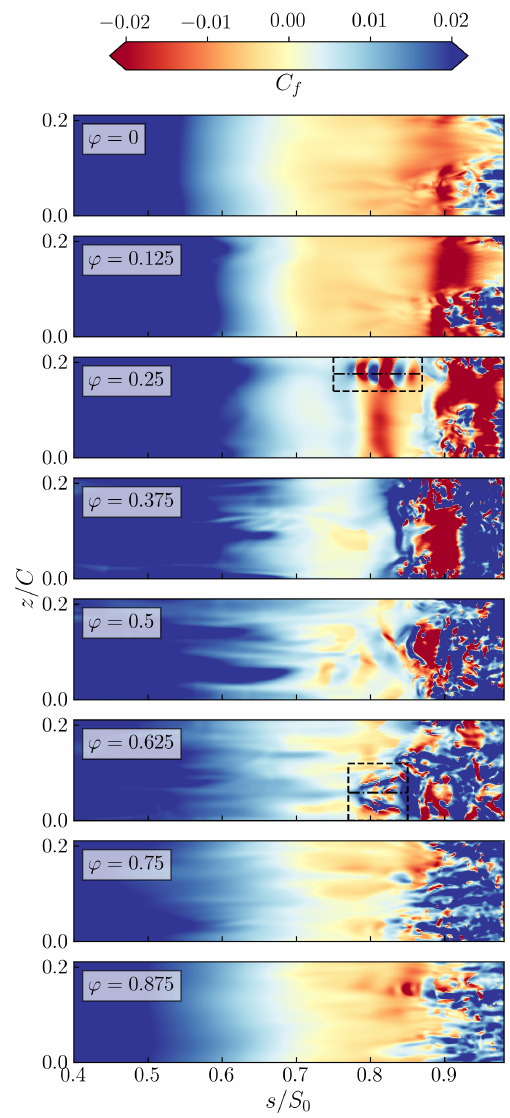
Figure 3. Instantaneous time–space skin friction on the suction surface at eight consecutive phases, Re 2 = 86,000. The dashed boxes identify the regions shown in detail in Figure